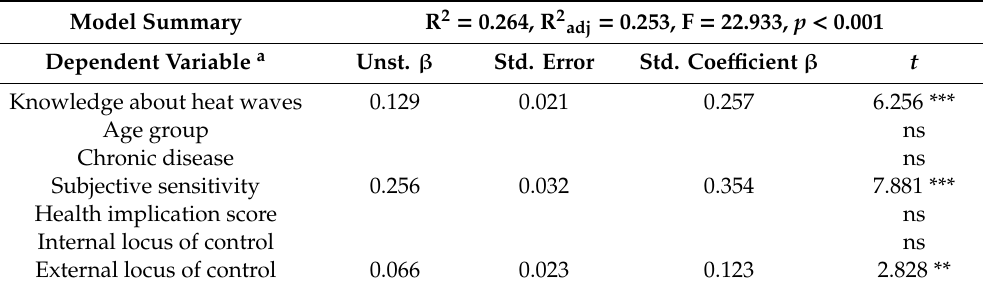
Table 5. Factors of heat risk perception (multiple